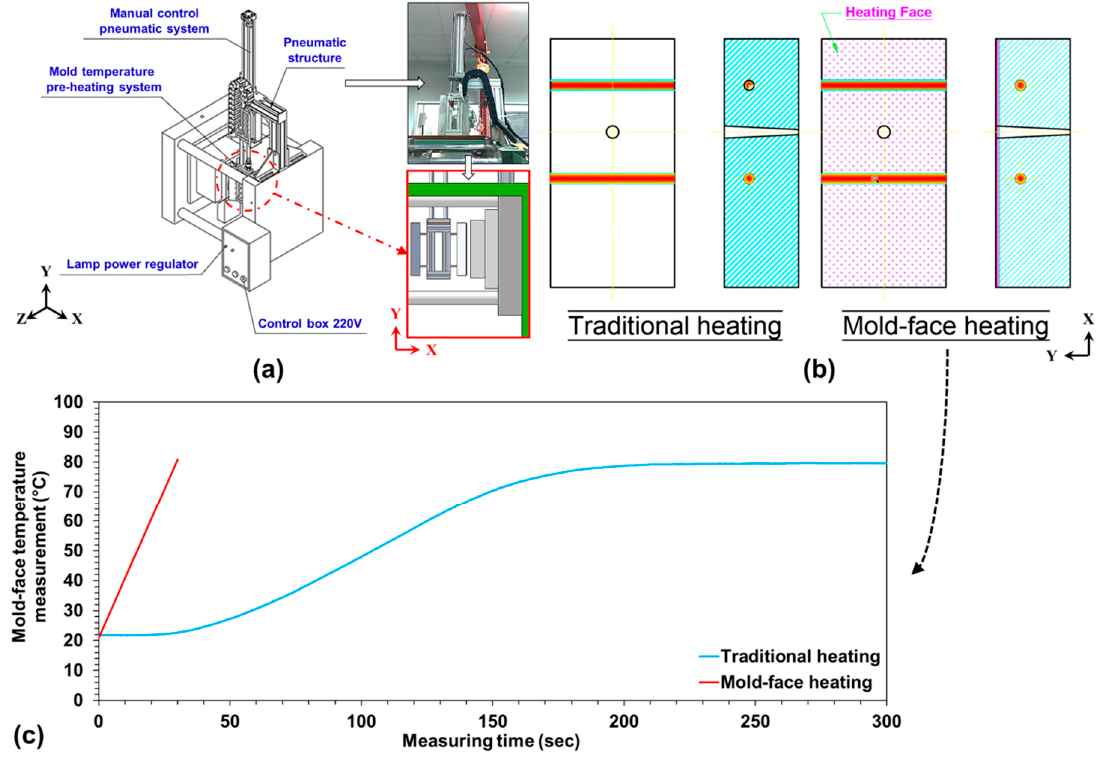
Figure 2. Design and application of infrared heater: ( a ) schematic of the infrared heater; ( b ) heating mechanisms when using traditional and infrared heating methods; and ( c ) trend of mold-face temperature when using traditional and infrared heating.